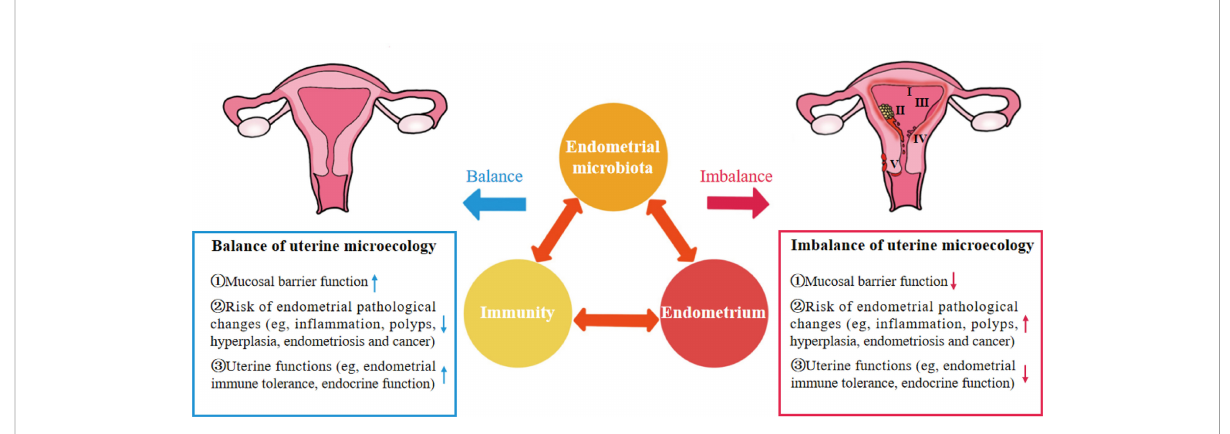
FIGURE 1 “ Iron triangle ” of regulating the uterine microecology: endometrial microbiota, immunity and endometrium. I , Chronic Endometritis; II , Endometrial cancer; III , Endometrial hyperplasia; IV , Endometrial polyps; V ,